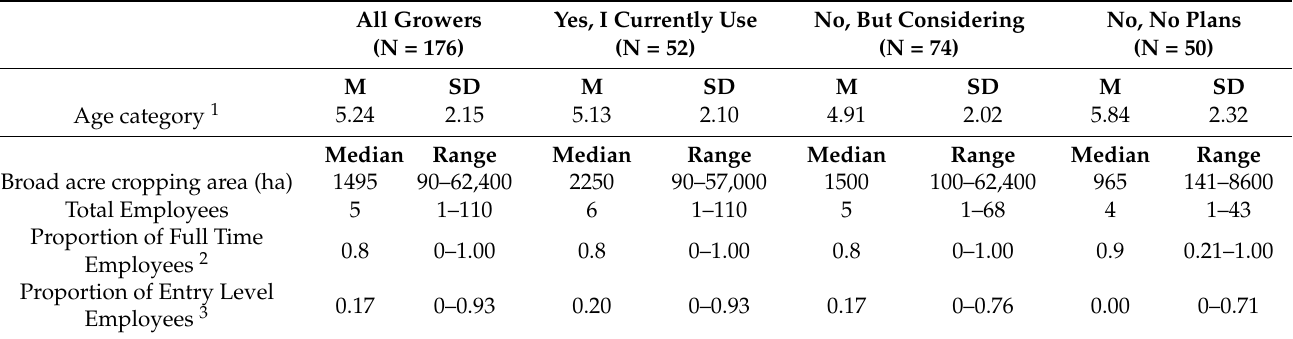
Table 3. Descriptive statistics for demographics by Automated Technology Adoption